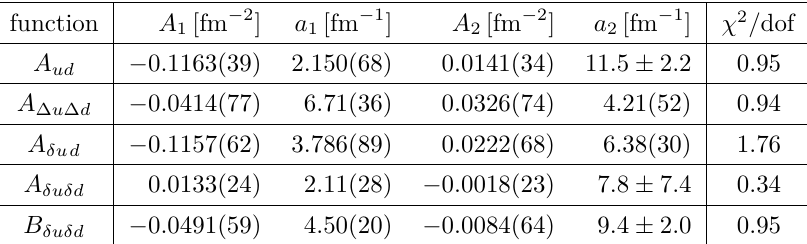
Table 2 . Parameters for the fit (5.15) of twist-two functions at py = 0 in the region 5 a ≤ y ≤ 20 a . Throughout this section, we consider the data for graph C 1 and light quarks on our lattice with L = 40